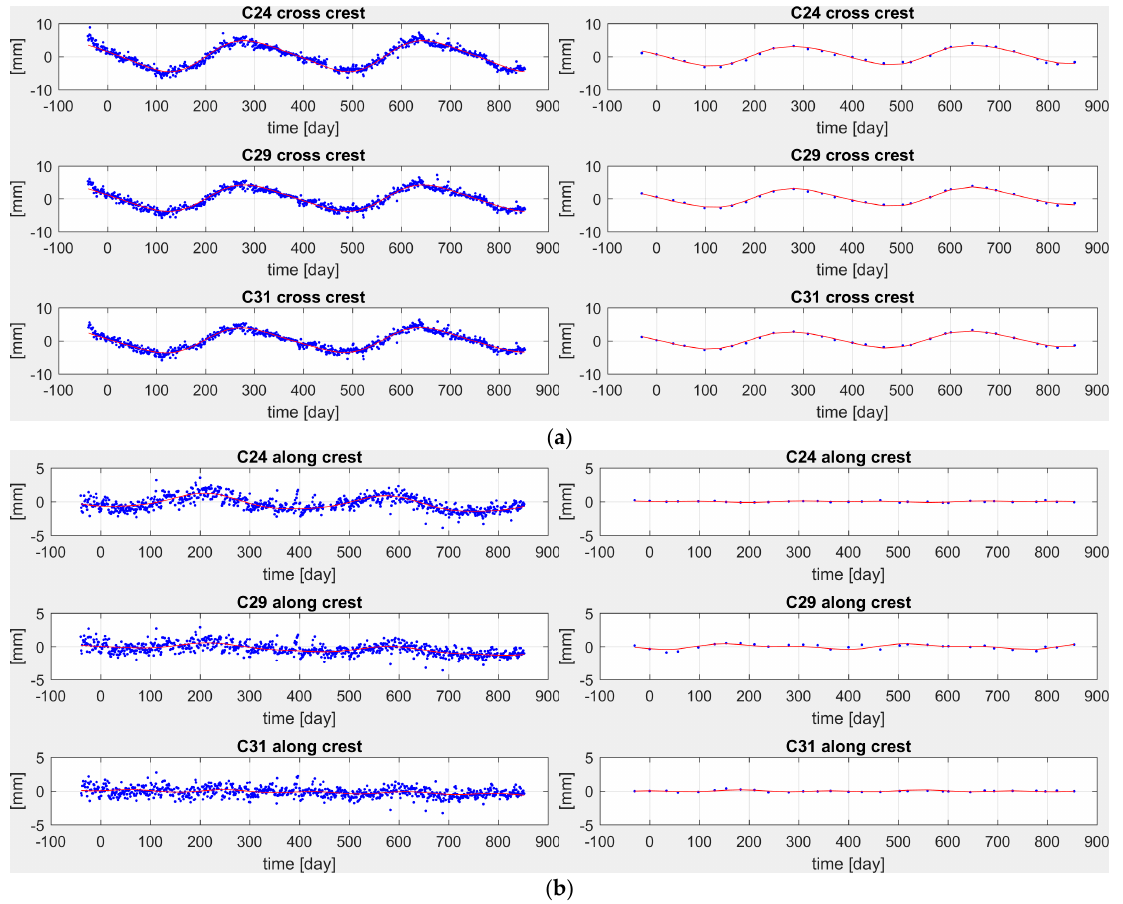
Figure 8. ( a ) Estimated models (red line) and observed displacements (blue dots) in the cross-crest direction by GNSS ( left ) and pendulums ( right ). ( b ) Estimated models (red line) and observed displacements (blue dots) in the along-crest direction by GNSS ( left ) and pendulums ( right ).